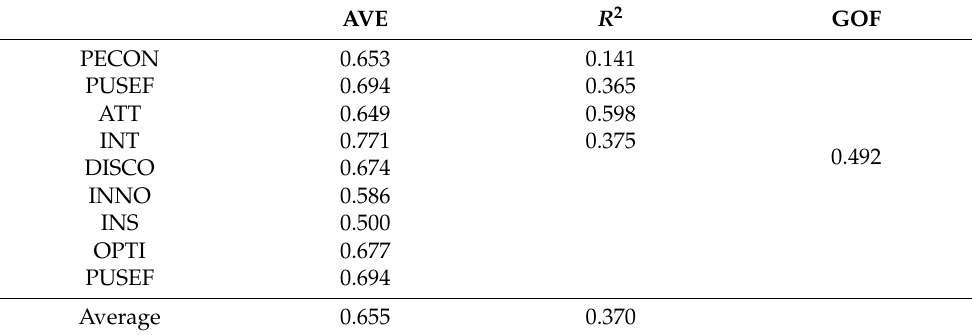
Table 9. Goodness of